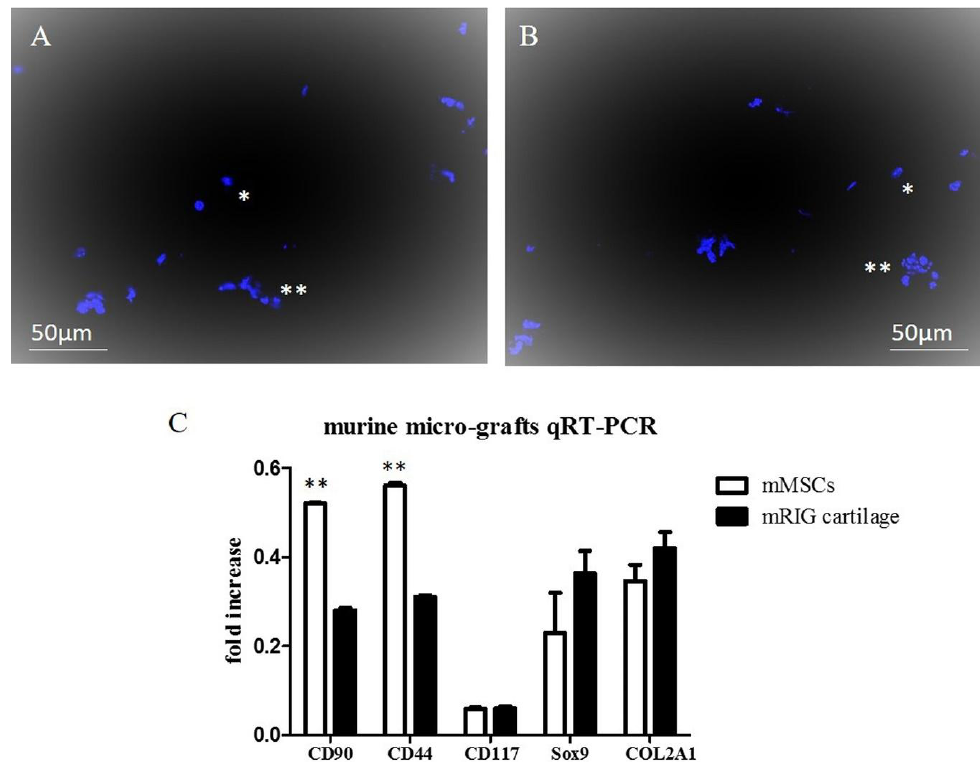
Figure 1. ( A , B ): Hoechst 33342 staining on micro-grafts suspension obtained from murine auricular cartilage. (*) represents single nuclei cells, while (**) represents clusters of micro-grafts containing small groups of living cells. Magnification at 20 × . ( C ): Gene expression analysis of the indicated specific markers as determined by qRT-PCR. qRT-PCR analyses were performed on murine MSCs cultivated in proliferative medium for 7 days and on micro-grafts obtained from murine auricular cartilage. The graph shows the fold induction of gene expression expressed in arbitrary units. Statistical significance values are indicated as *: p < 0.05, **: p < 0.001.